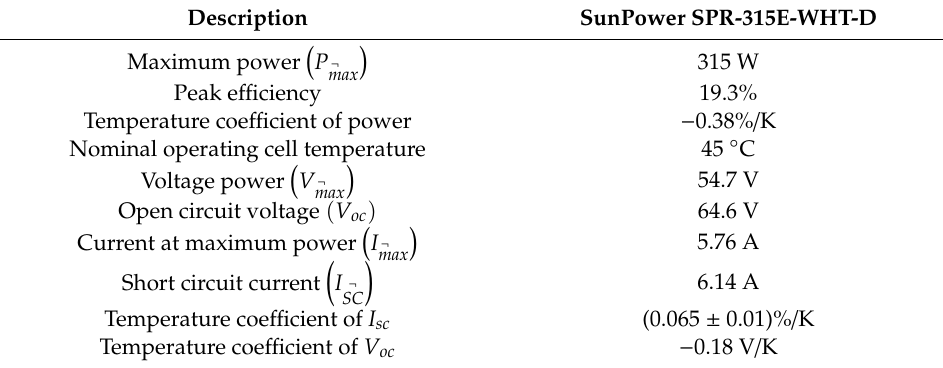
Table 3. Electric characteristics of SunPower SPR-315E-WHT-D 17.9 W / ft 2 (192.9 W / m 2